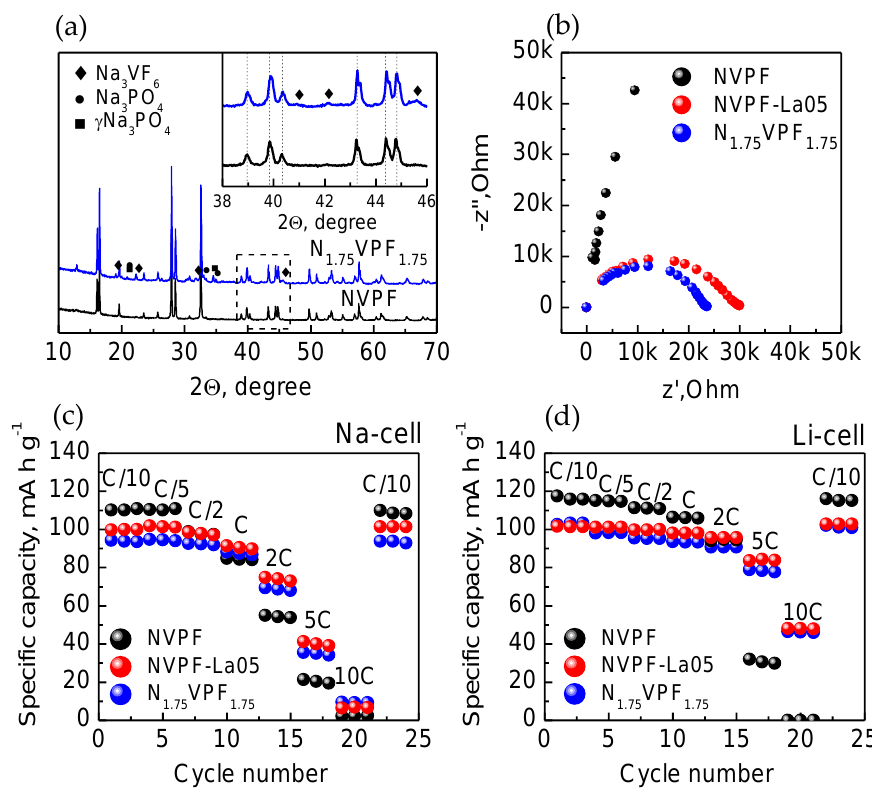
Figure 6. XRD pattern of N 1.75 VPF 1.75 ( a ), impedance spectra ( b ), and discharge capacity vs. cycling rate (C/10–10C) plots upon cycling of N 1.75 VPF 1.75 in the Na cell ( c ) and Li cell ( d ) within the 3.0–4.5 V range in comparison with NVPF and NVPF-La05 ( d ).